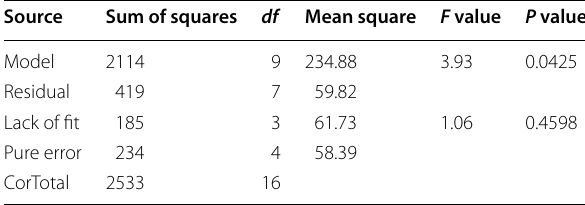
Table 2 ANOVA results for regression model Source